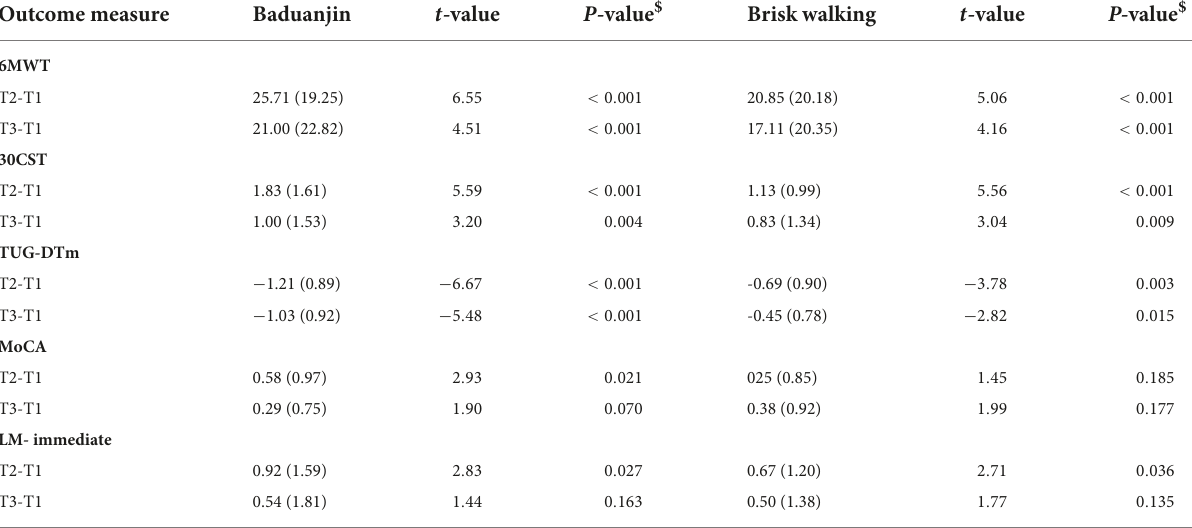
TABLE 3 Post-hoc analysis of the within-group factor.